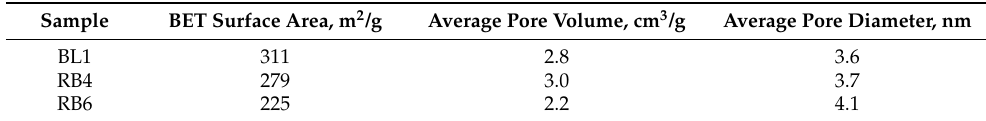
Table 1. Characteristics of BL1, RB4 and RB6 matrices by BET analysis. Sample